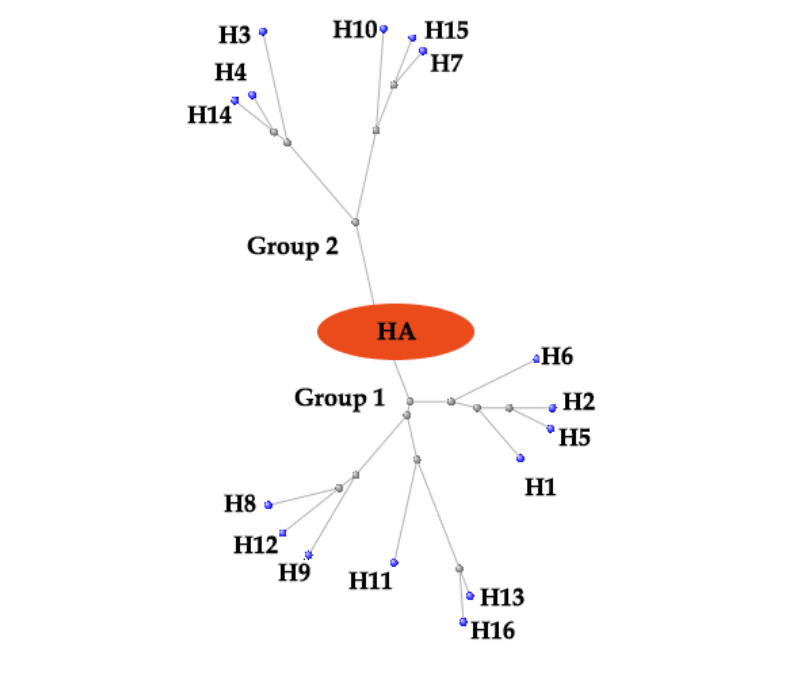
Figure 1. The phylogenetic tree of influenza A virus hemagglutinins (HAs). Constraint- based Multiple Alignment Tool (COBALT) was used and then the figure was revised with Photoshop software. Tree method: Fast Minimum Revolution; Max Seq. Difference: 0.85; Distance: Grinshin General Protein. Grey dots represent nodes; Blue dots represent 16 subtypes of influenza A virus HA